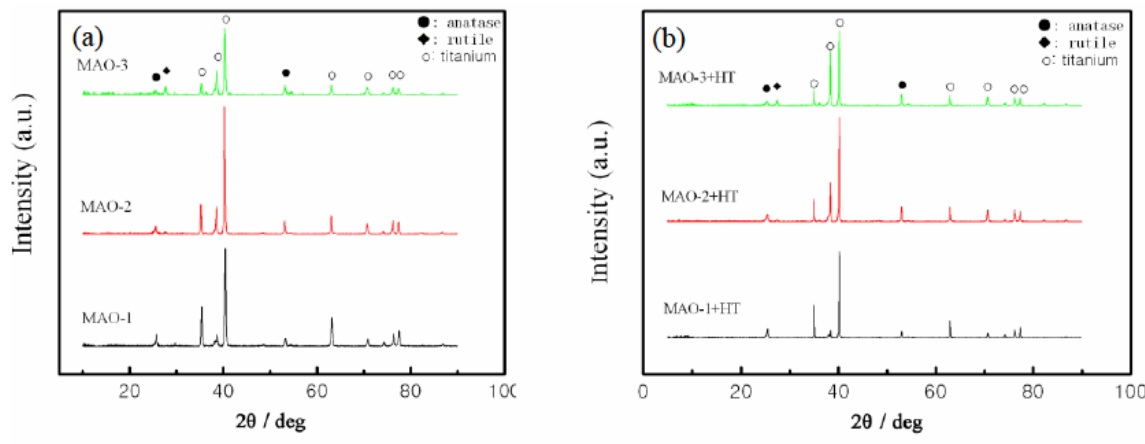
Table 2: Ratio of anatase and rutile phases of MAO coated Ti sub- strates before and after heat treatment Coatings Ratio of anatase and rutile MAO-1 Only anatase MAO-2 Only anatase MAO-3 10.28 MAO-1+HT 8.45 MAO-2+HT 1.81 MAO-3+HT